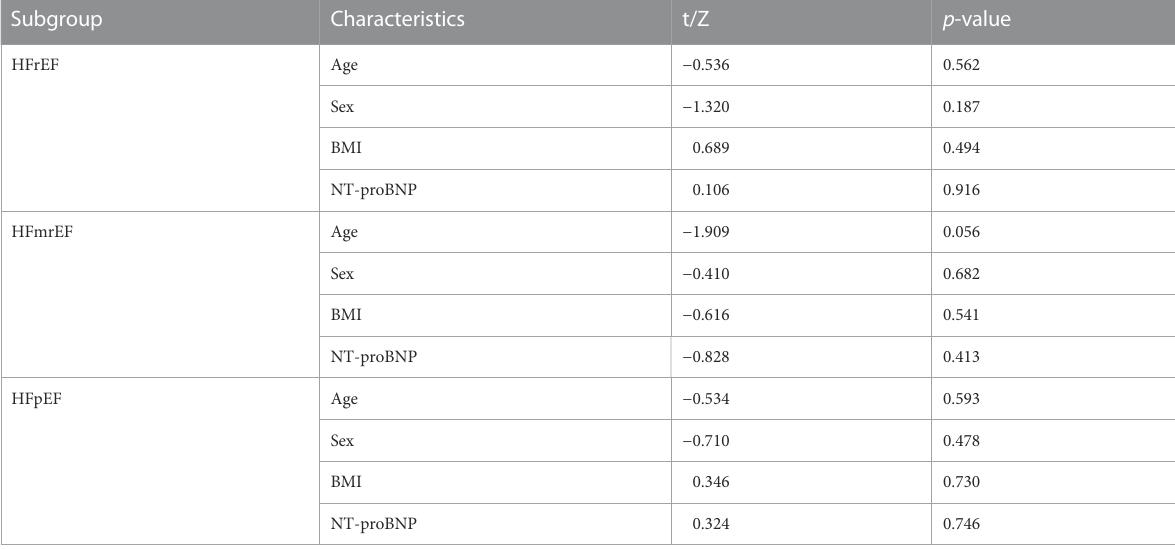
TABLE 4 subgroup baseline characteristics of patients.